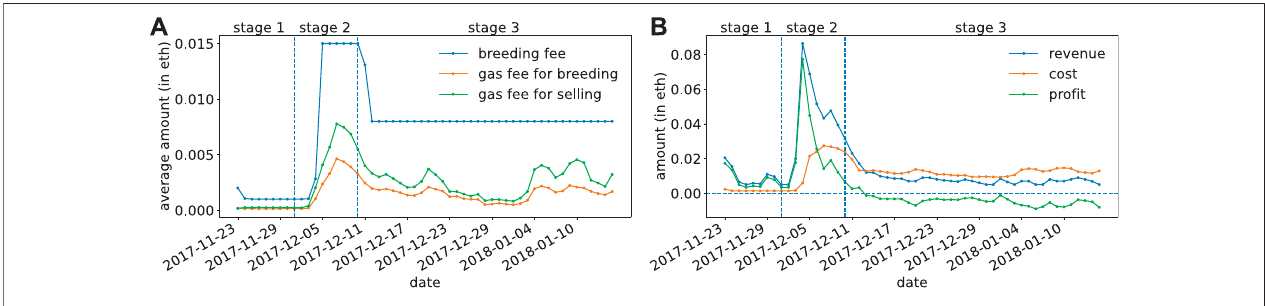
FIGURE 9| The loss of pro fi t in kitty sales. (A) The average breeding fee, gasfee for breeding, and gas fee for selling a kitty through SalesAuction contract on each day. (B) The revenue (median price of kitties), cost, and pro fi t for breeding and selling a kitty on each day. Dotted lines separates the stage 1, 2 and 3.